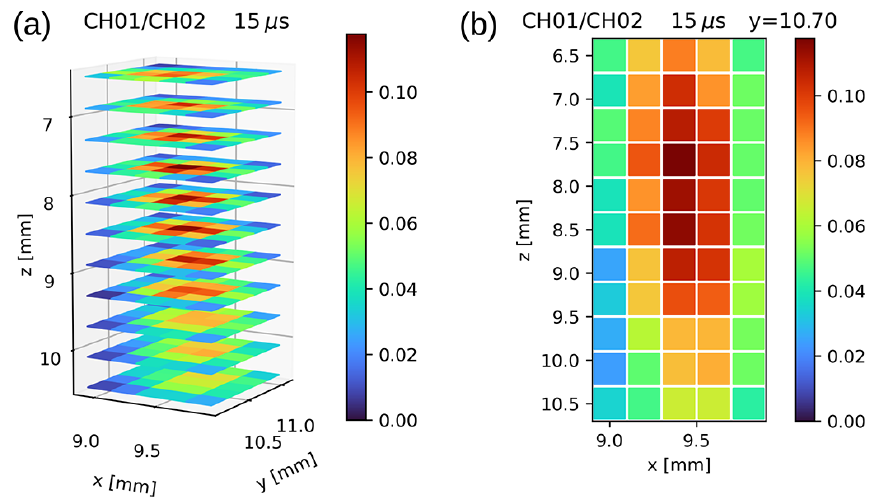
Figure 10. Overall view (a) and x – z section (b) of the results of the telescope mapping of the first session (13 January 2021) showing the normalized signal as a function of the x – y – z positions at a chosen range (15µs – 2250ma.g.l.).